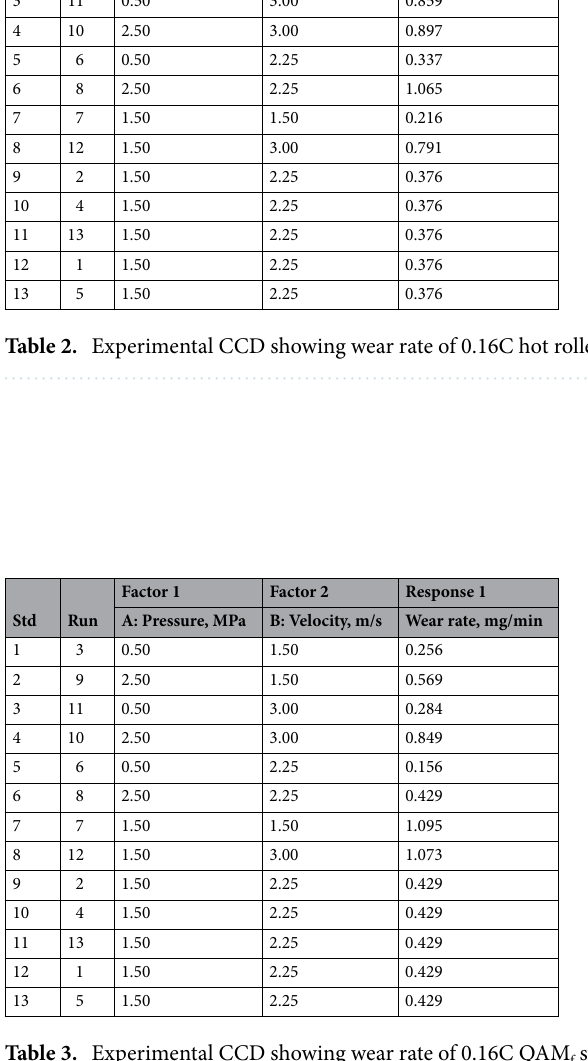
Table 3. Experimental CCD showing wear rate of 0.16C QAM f